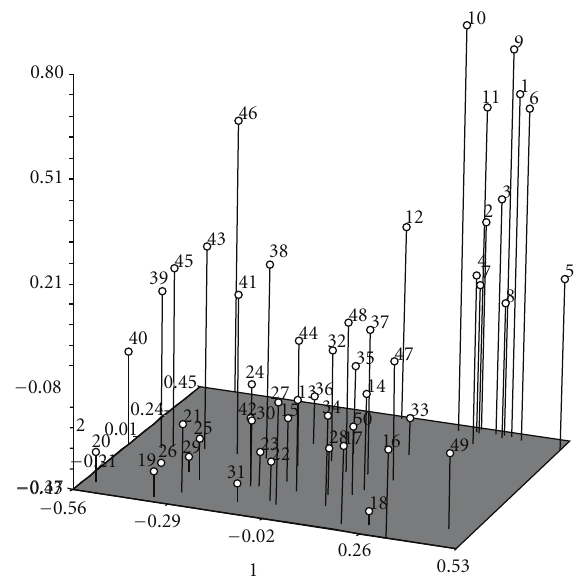
Figure 2: Three-dimensional graph of 50 upland rice accessions based on 12 quantitative traits.